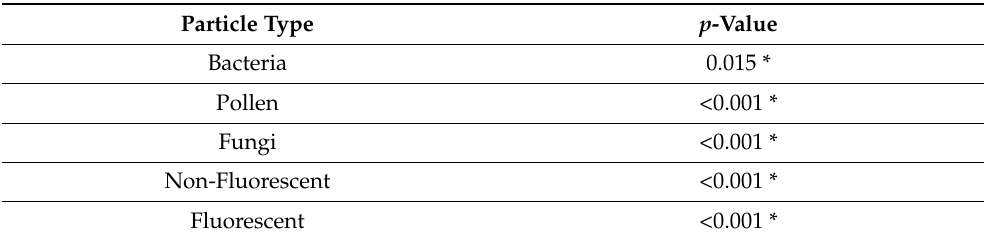
Table 3. Results of testing the homogeneity of means of concentration ratios by particle type with all activities included.